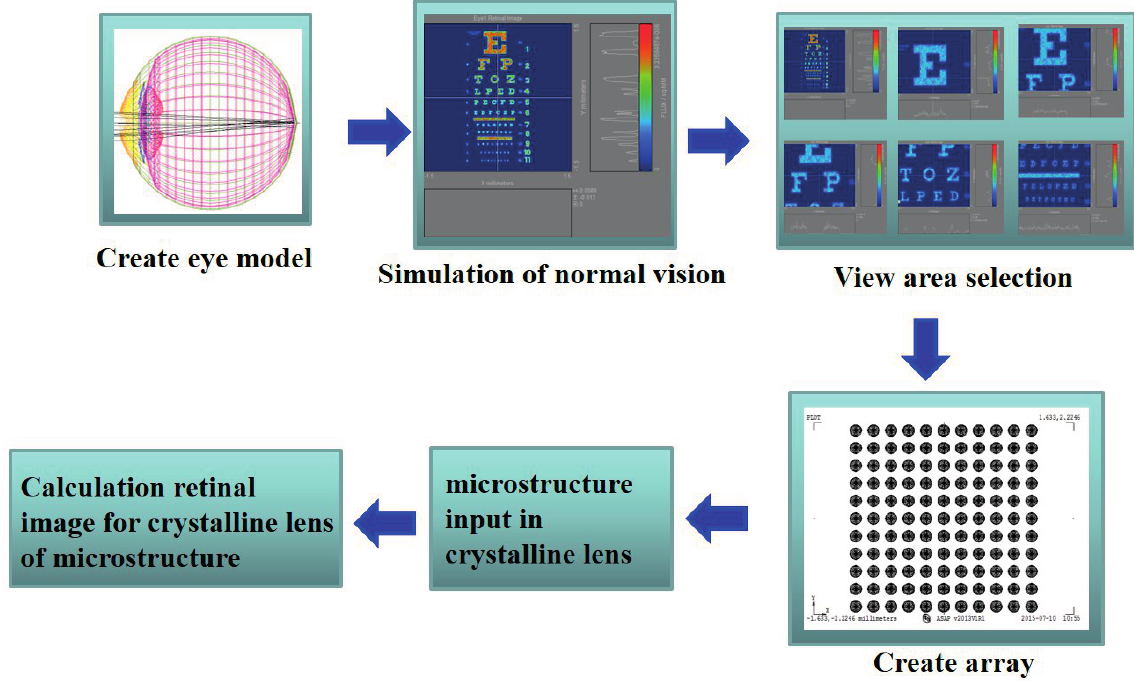
Figure 2. Research flow